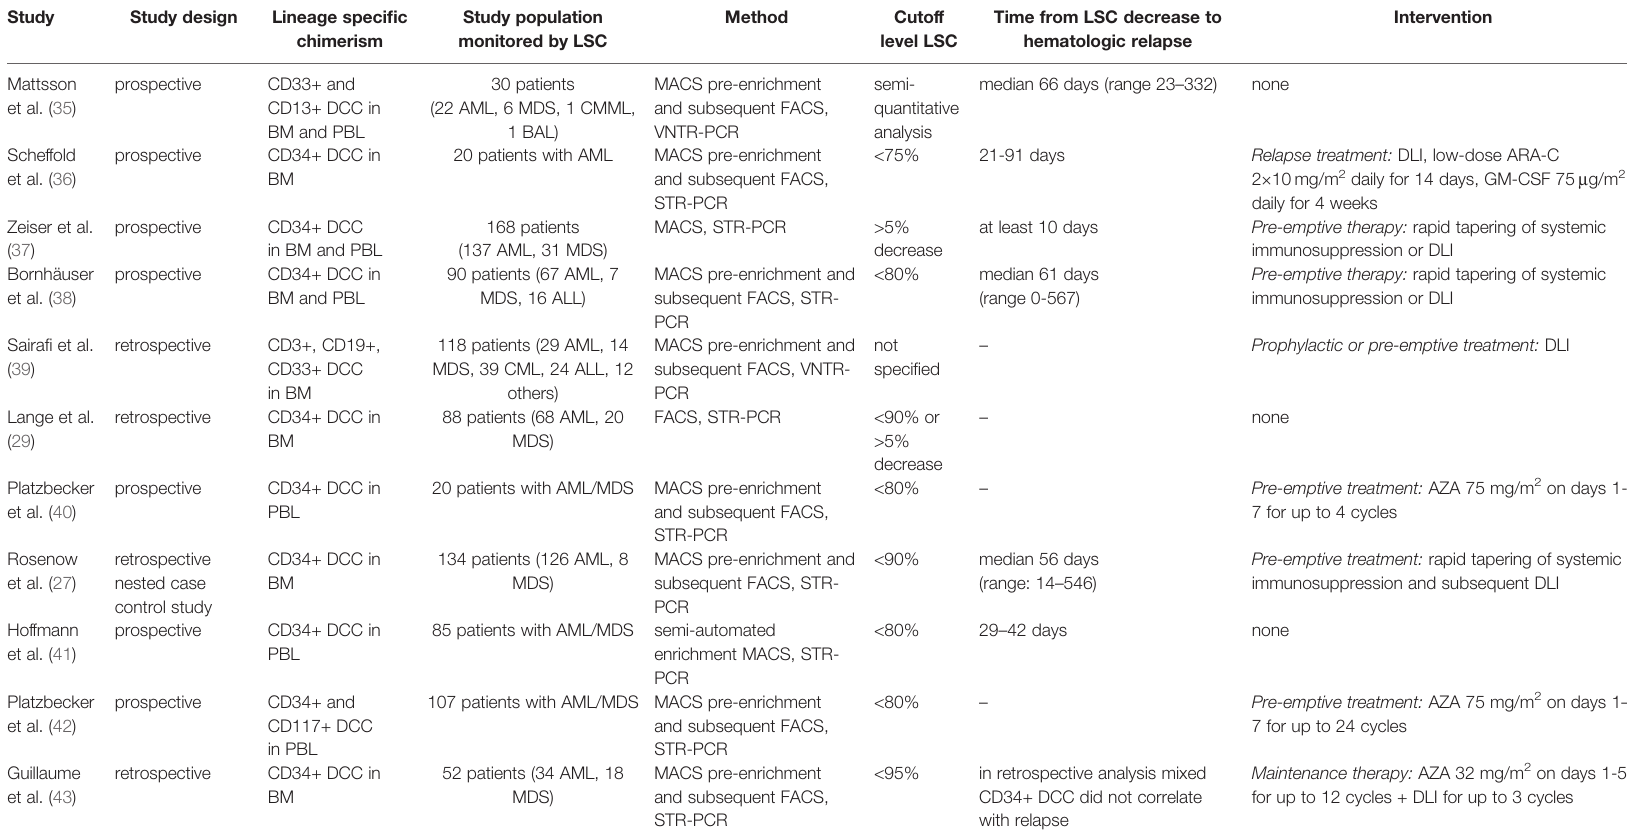
TABLE 1 | Selection of published data on MRD detection with subset chimerism performed in AML or MDS patients following allogeneic